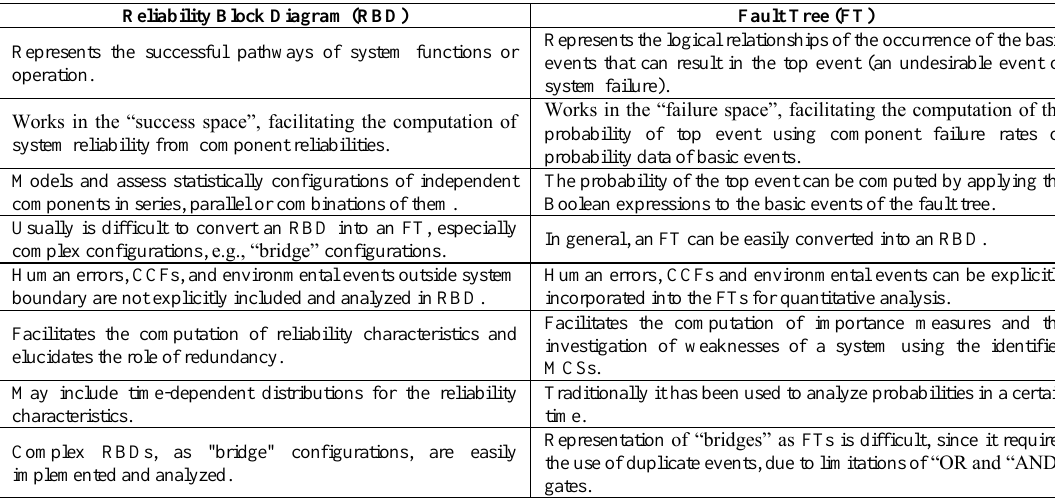
Table 1. Comparison of RBD and FT